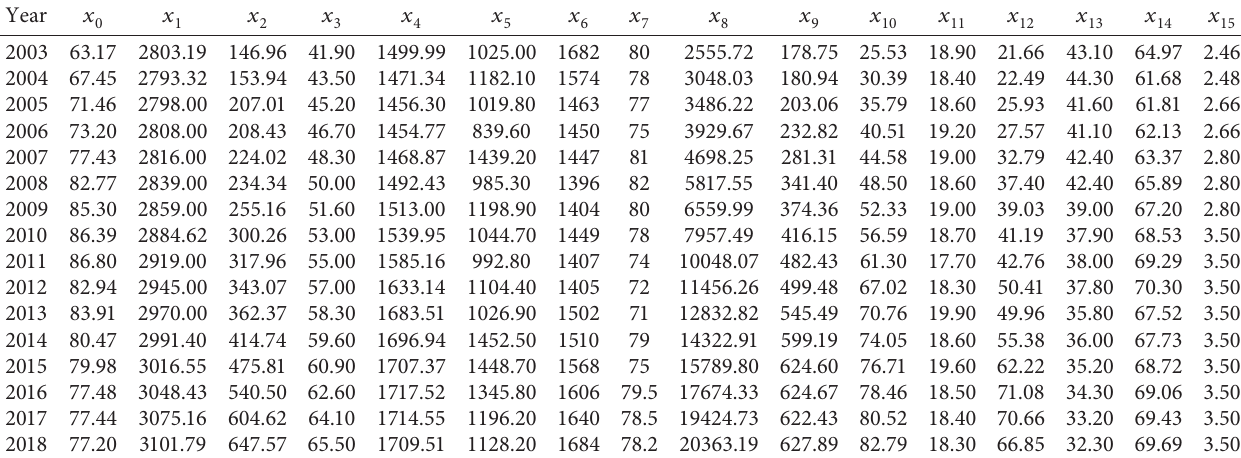
Table 1: Annual statistics on water consumption and other indicators in Chongqing from 2003 to 2018.